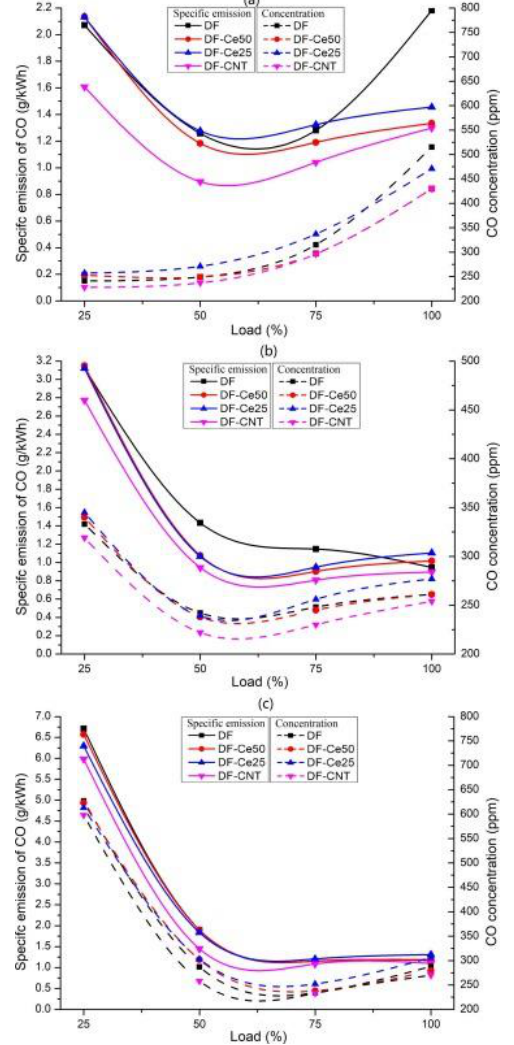
Fig. 4. CO emission from the tested fuels at engine speeds of 1490 rpm (a), 1855 (b), and 2200 rpm (c) [24]